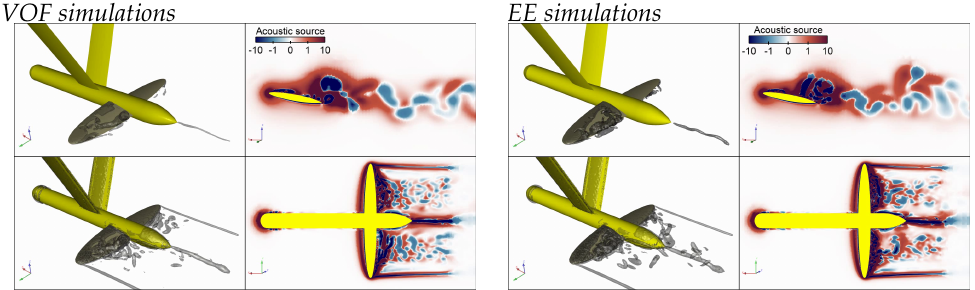
Figure 25. Snapshots from VOF ( left ) and EE ( right ) simulations illustrating instantaneous cavitation evolution and acoustic source term distribution. Top left frames: isosurfaces of α g = 0.1. Bottom left frames: isosurfaces of Q ∗ = 1. Right frames show the non-dimensional acoustic source term. Top right frames: cut plane at midchord of left wing. Bottom right frames: cut plane at middle of cavitator. Animations of the cavitation and acoustic source evolution are given as Supplementary Material (Video